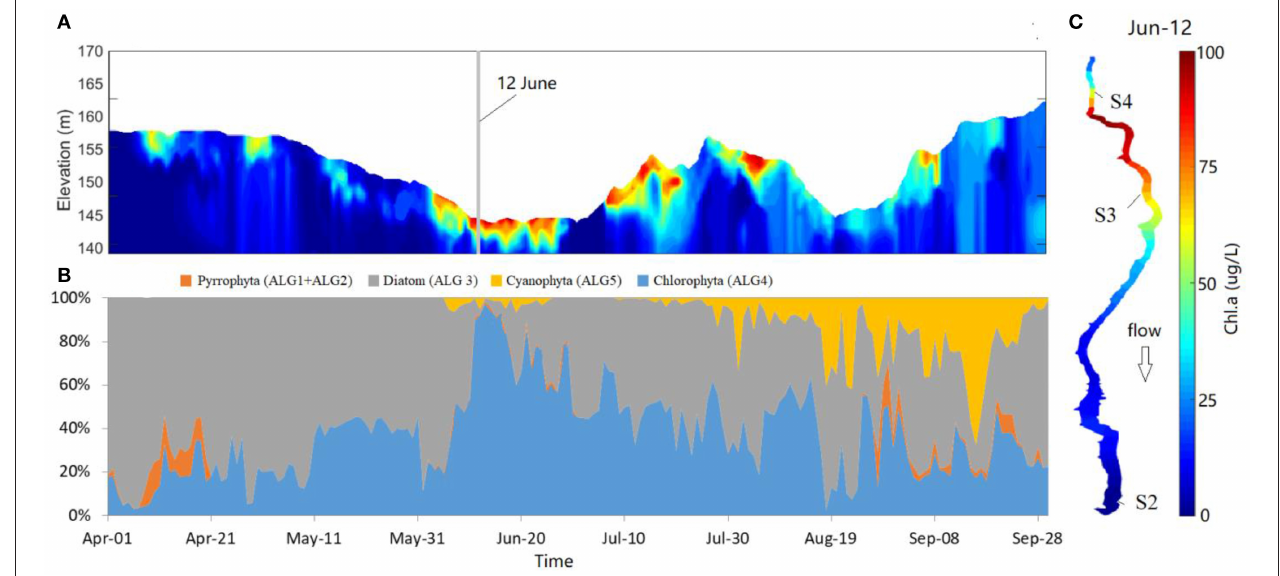
FIGURE 7 | (A) Temporally simulated Chl.a at S4 in stratified period (April–September). (B) Seasonal succession of phytoplankton composition at S4 at the same period as in panel (A) . (C) Space distribution of surface Chl.a on June 12, 2012, corresponding to the gray background line in panel (A) .